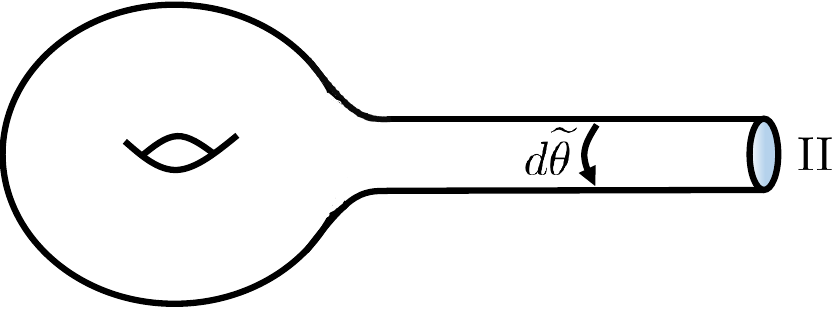
Figure 5 . Depiction of the 12D geometry associated with F-theory and IIB as an edge mode in the special case where the axio-dilaton is constant. Here, we have passed from the (10 ; 2) signature spacetime to one in which a dual winding coordinate e (cid:18) appears. This takes us to a dualized spacetime of signature (11 ; 1) and in which the standard elliptic (cid:12)ber of F-theory appears